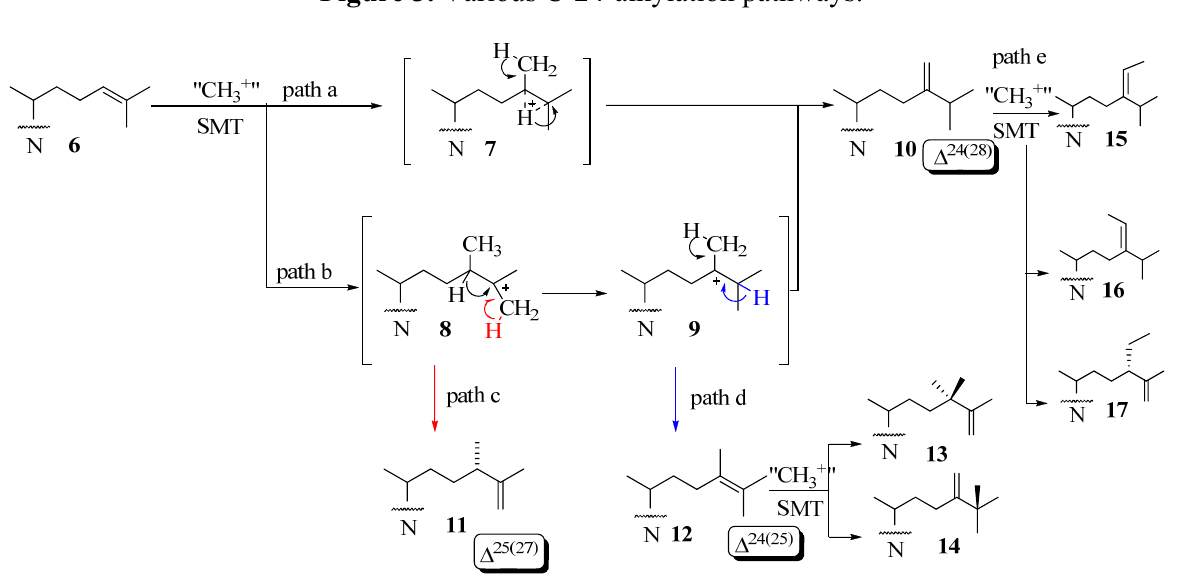
Figure 3. Various C-24-alkylation